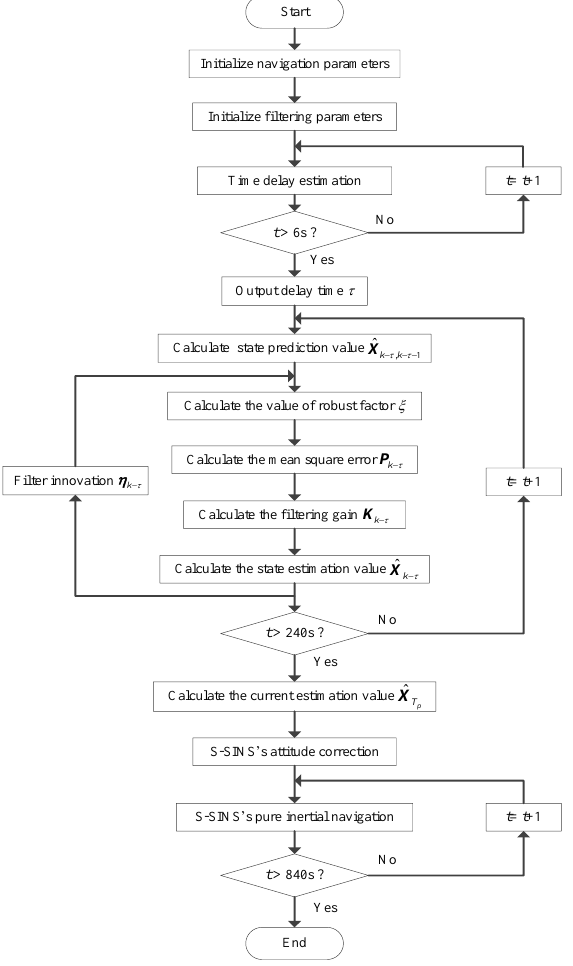
Figure 2. Flow chart of transfer alignment based on adaptive H∞ filtering method with delay compensation.